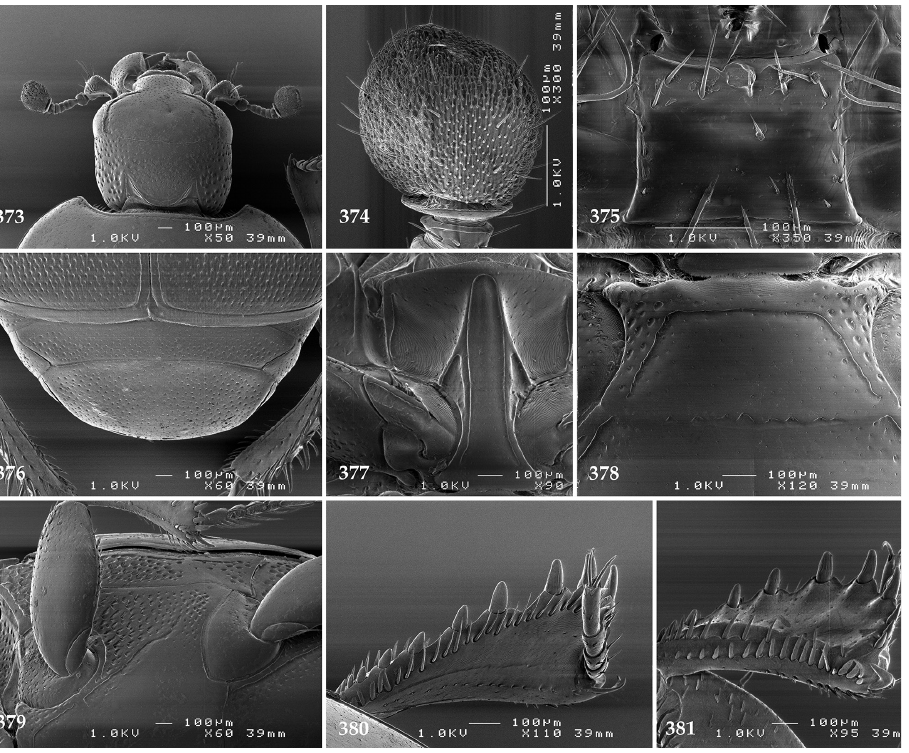
Figures 373–381. 373 Saprinus ( Saprinus ) chathamensis sp. n. head, dorsal view 374 antennal